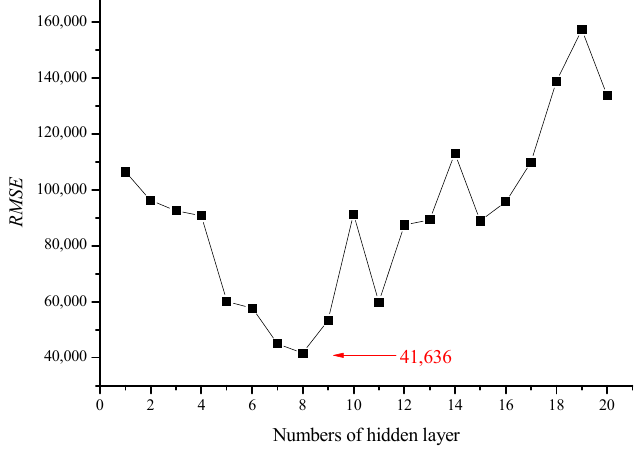
Figure 1. RMSE for various numbers of hidden layers.